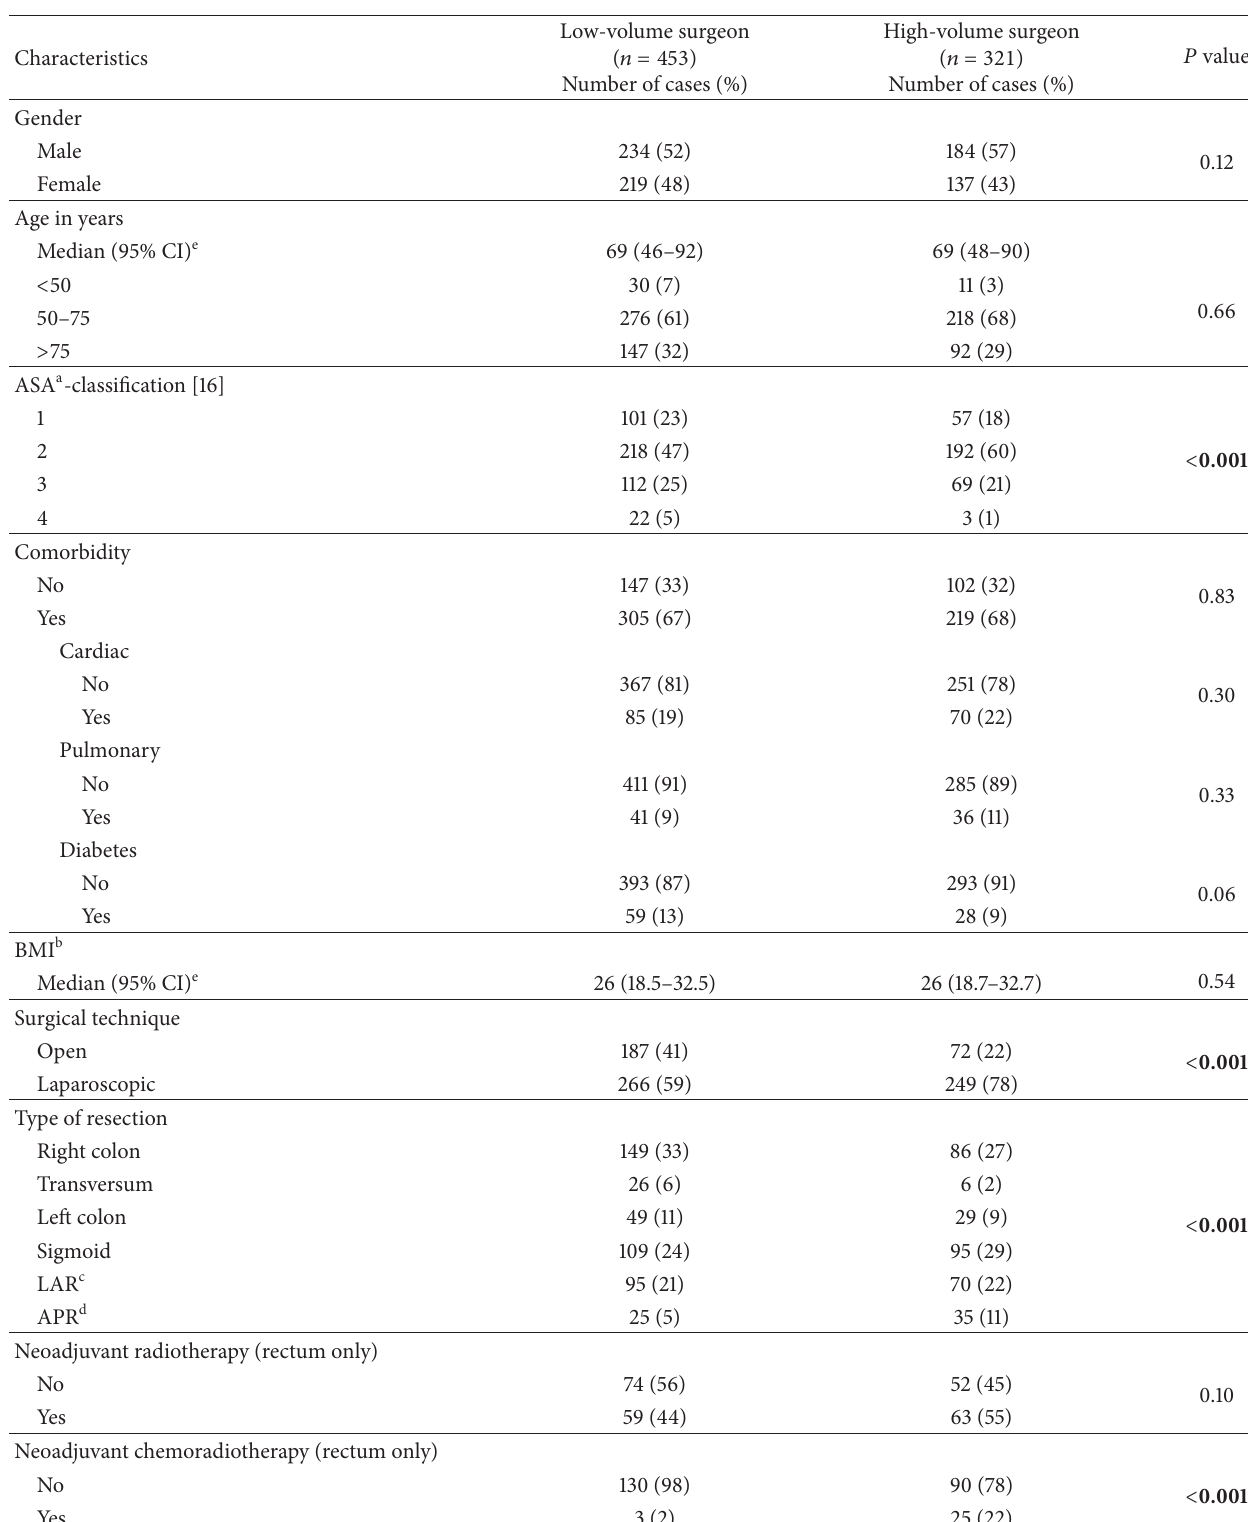
Table 1: Preoperative